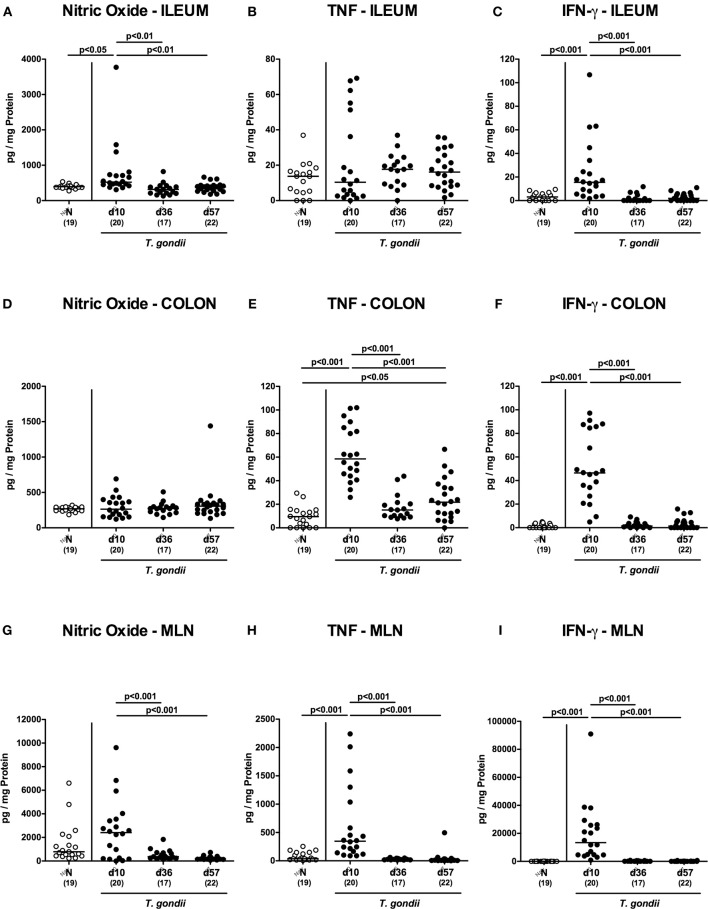
Intestinal pro-inflammatory mediator secretion over time following peroral low-dose T. gondii infection. Mice were perorally infected with one cyst of T. gondii on day 0 and surveyed at days (d) 10, 36, and 57 post-infection (p.i.; closed circles). Naive (N) mice served as uninfected controls (open circles). Pro-inflammatory mediators such as (A,D,G) nitric oxide, (B,E,H) TNF and (C,F,I) IFN-γ were measured in ex vivo biopsies taken from distinct intestinal compartments including the (A–C) ileum, (D–F) colon and (G–I) mesenteric lymph nodes (MLN) at respective time points. Medians (black bars), levels of significance (p-values) as determined by one-way ANOVA test followed by Tukey post-correction for multiple comparisons and numbers of analyzed mice (in parentheses) are indicated. Data were pooled from four independent experiments.